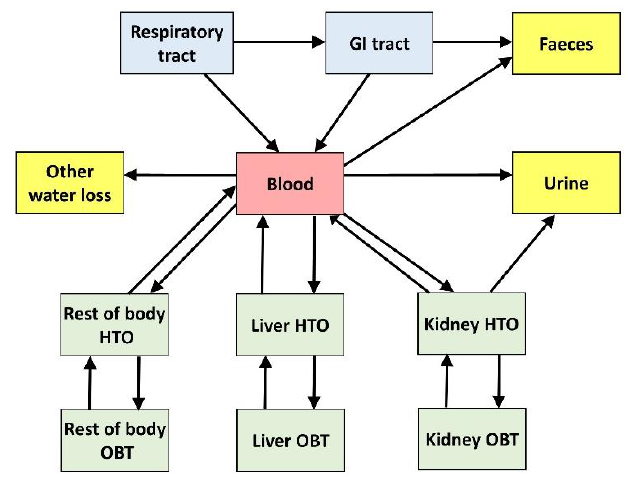
Figure 5. Structure of the rat biokinetic model.